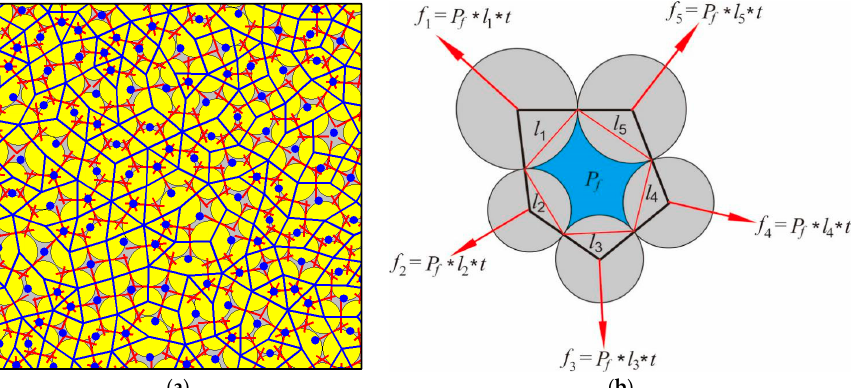
Figure 2. Particle flow code model used in the fluid ‐ mechanical simulation: ( a ) fluid network (yellow circles are solid particles; domains (blue polygons), the centers of domains (blue circles), and flow channels (red lines) making up the fluid network); and ( b ) mechanical coupling. Red arrows are resultant forces applied to the particles surrounding the domain due to the fluid pressure P f . Flow of viscous fluid in the channel (Figure 2a, red lines) is driven by the differential pressure between the two domains (Figure 2a, blue polygons), and it is modeled using the Poiseuille Equation,